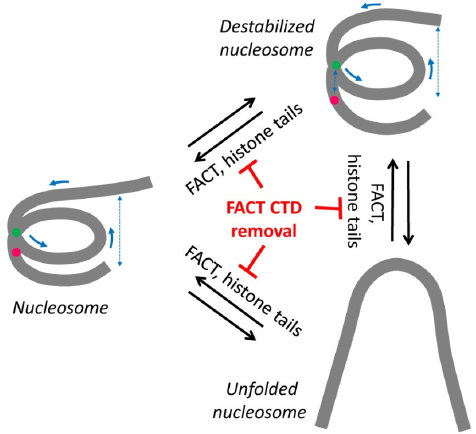
Figure 5. A model of FACT action during nucleosome stabilization. Histone tail removal results in destabilization of nucleosomes accompanied by partial uncoiling of the nucleosomal DNA. On a small fraction of the templates, nucleosomes are dramatically unfolded. The three transitions in the structure of the nucleosomes are reversible and likely require the presence of CTD domains on both FACT subunits; CTD removal blocks the transitions.